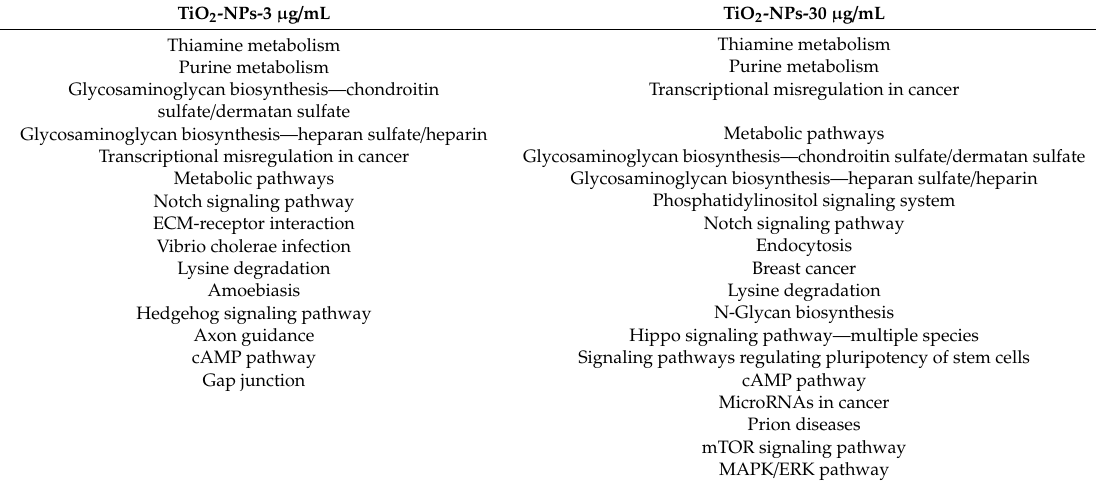
Table 5. Altered canonical pathways by TiO 2 -NPs in HCT116